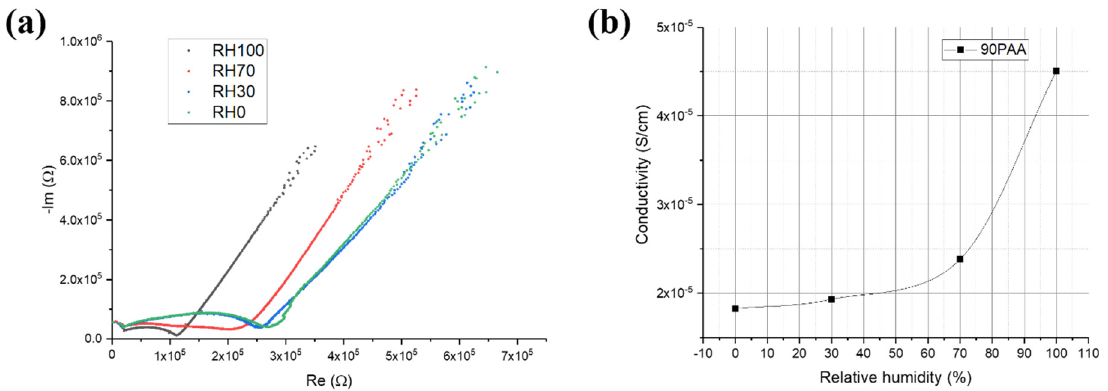
Figure 9. ( a ) Electrical response of the 90PAA sample to RH at 25 °C (RH0, RH30, RH70 and RH100, representing relative humidity concentrations of 0%, 30%, 70% and 100%, respectively); ( b ) the dependence of the grain component of conductivity on the relative humidity content.